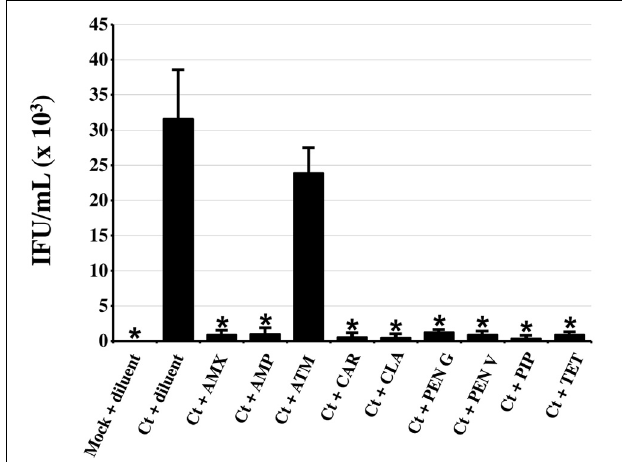
FIGURE 3 | Penicillin-exposure significantly reduces chlamydial infectivity. HeLa cells were C. trachomatis -infected and incubated in the absence of antibiotic for 24h. Infected and uninfected cultures were then refed with medium containing each antibiotic of interest at the 1X concentrations ( Table 1 ). Thirty hours post-antibiotic addition (54hpi total), infected cell lysates were collected and used for infectious titer analyses. Inclusion counts were averaged and used to calculate inclusion forming units (IFU)/mL. The average of three biologic replicates from one of three independent experiments ± s.e.m. is shown. Groups significantly different from the diluent-exposed, Ct-infected control are indicated by asterisks ( ∗ ), P ≤ 0.05 was considered